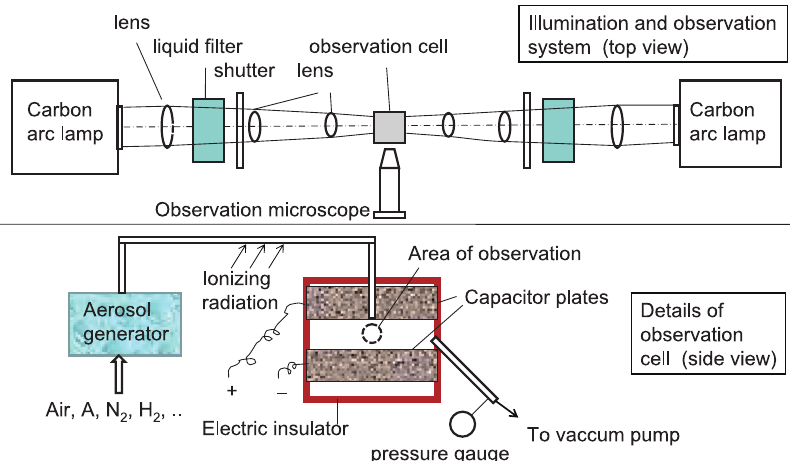
Fig. 13 Apparatus used by Ehrenhaft (1918) for the observation of photophoresis. Top: Light is concentrated by several lenses in the center of the observation cell. The observation is done through a microscope, per- pendicular to the direction of illumination. The dark field illumination permits the observation of parti- cles sizing down to tens of nanometers. The cell can be evacuated or pressurized and is made of an electrically insulating material. Bottom: Two metal plates serve as a capacitor to exert vertical forces on charged particles. The charging of the particles is done by ionizing